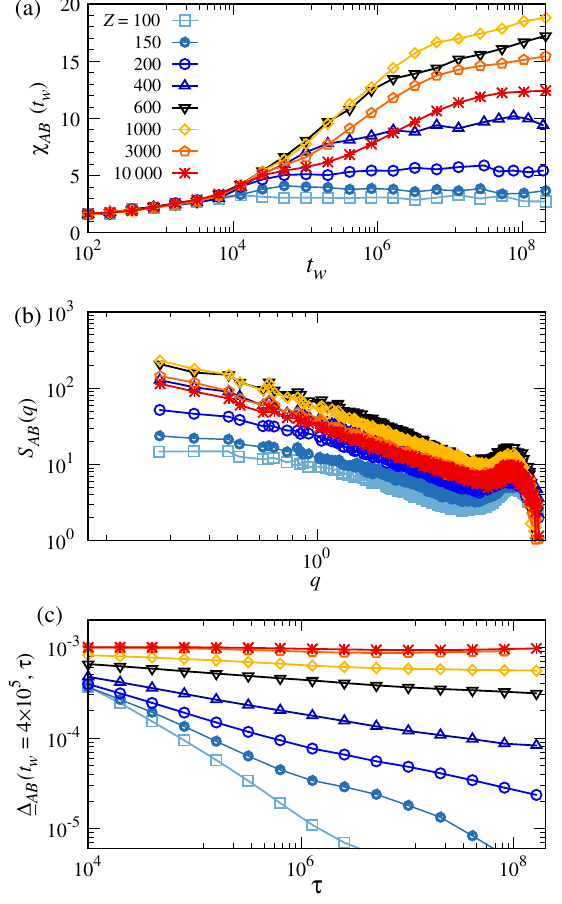
FIG. 4. Growing timescales and length scales in hard disk glasses. (a) Time evolution of susceptibilities χ pressures. (b) S indicated in (a). As q → 0 , S